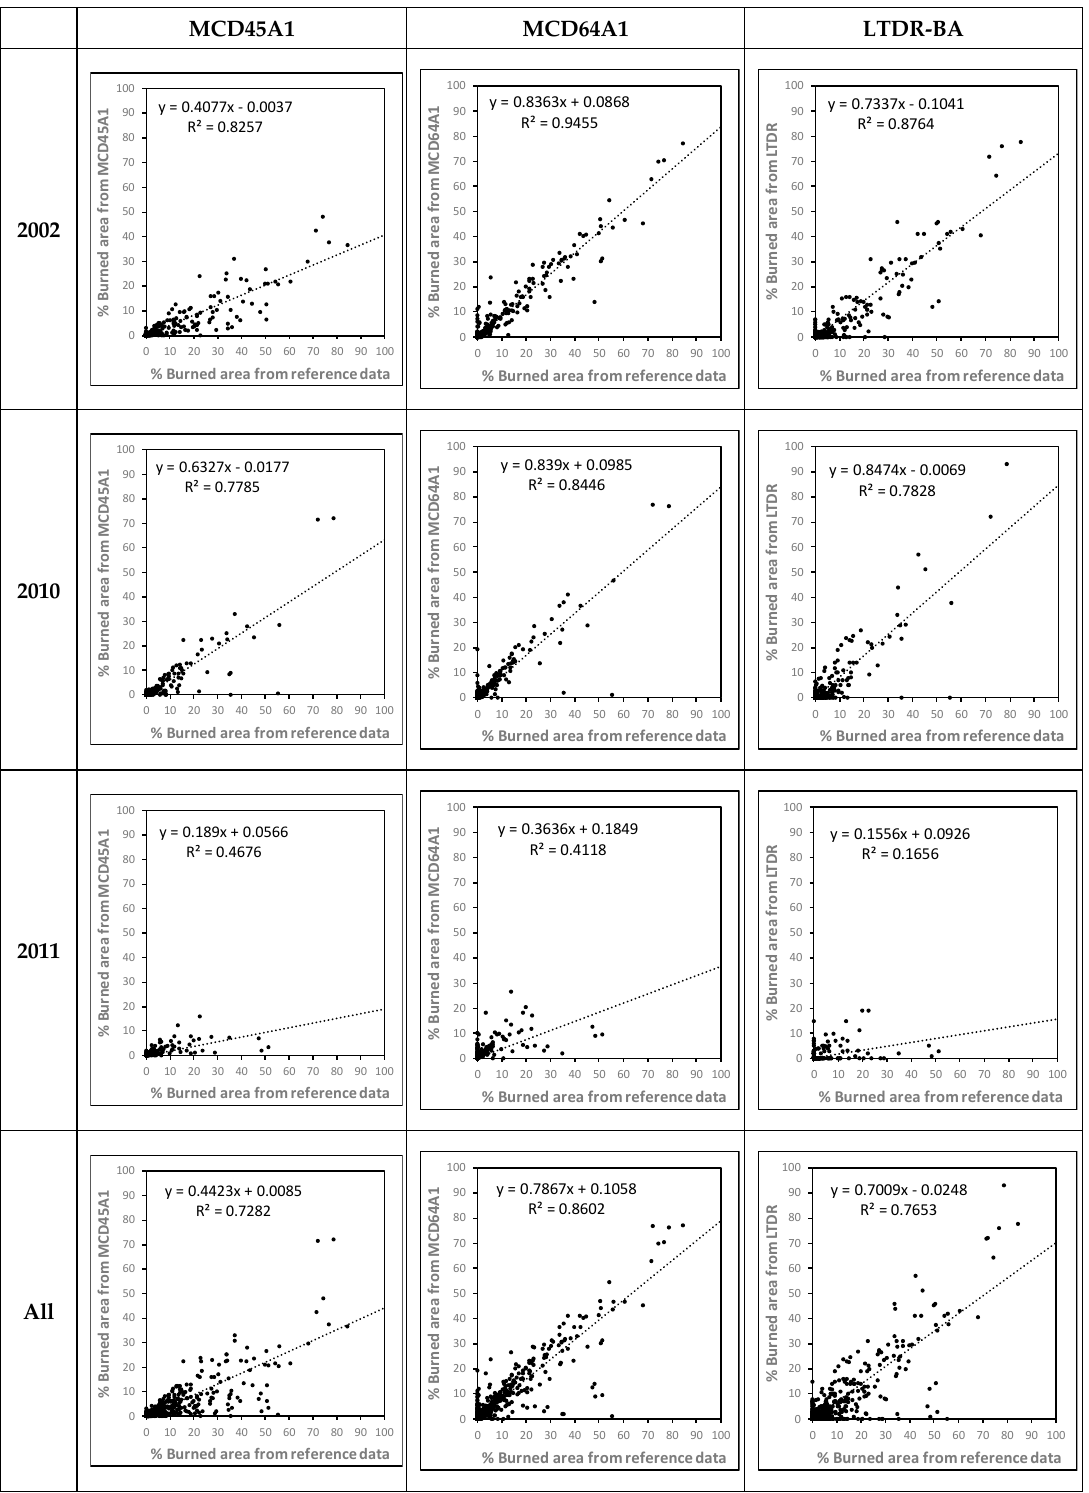
Figure 6. Scattering plots of the BA proportions in 50 km × 50 km grids from the different BA products vs reference data for years 2002, 2010, and 2011 for the Northeastern Siberian boreal region. p -value < 0.001 for all cases.